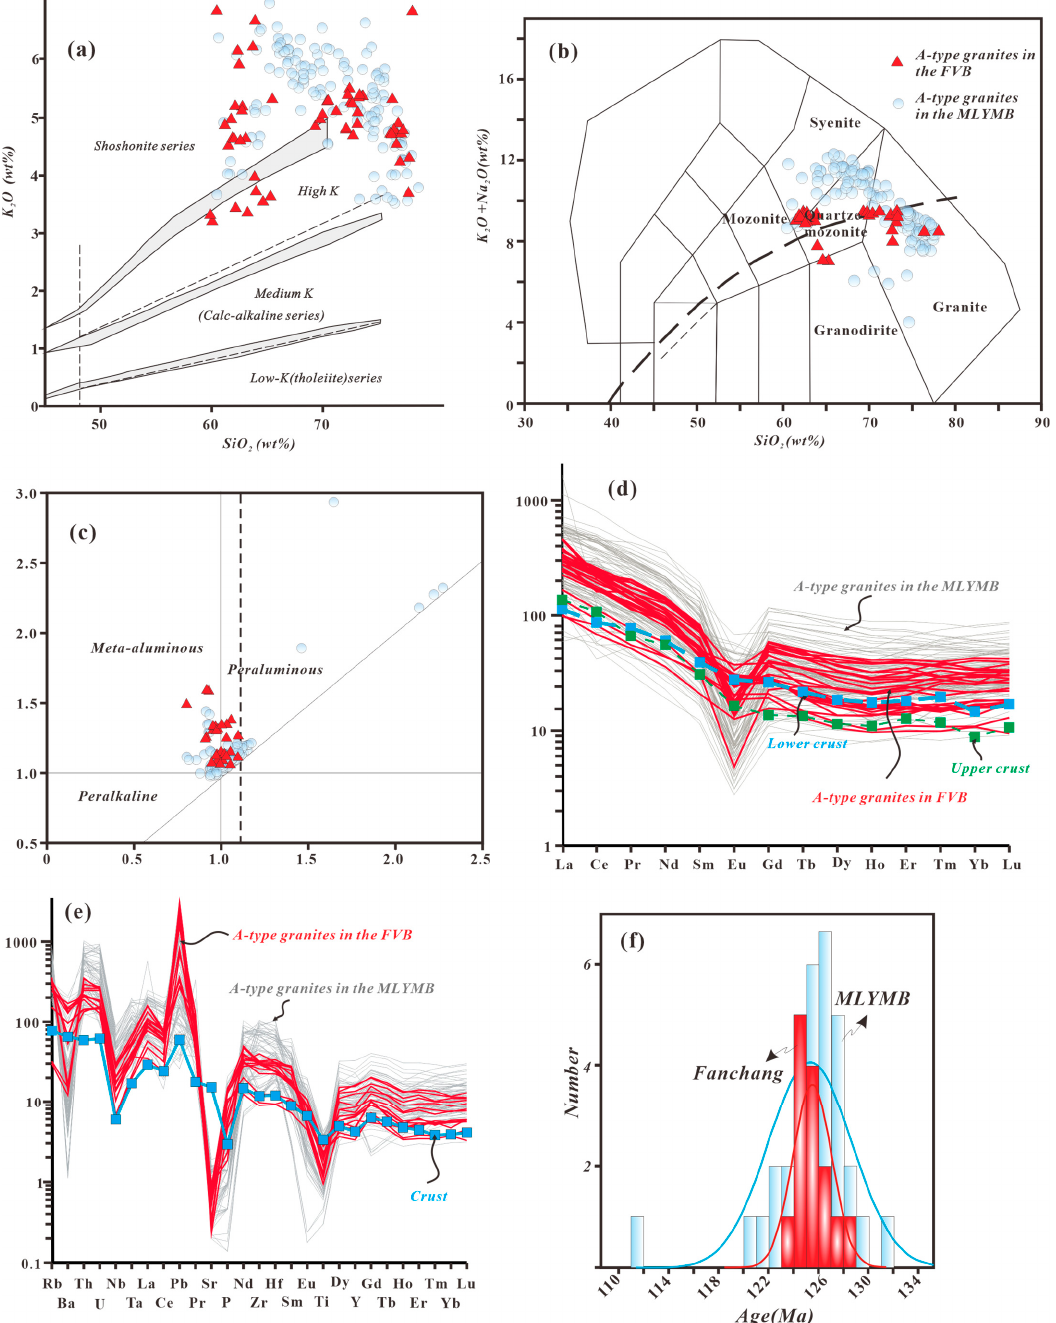
Figure 3. Some basic geochemical diagrams of A-type granites in the FVB and MYLMB. ( a ) K 2 O vs. SiO 2 diagram (after [148]); ( b ) TAS diagram (after [149]); ( c ) A/NK vs. A/CNK diagram (after [148]); ( d ) chondrite-normalized rare earth element patterns (normalization values after [150]), data of the lower and upper crusts are from [151]; ( e ) primitive mantle-normalized trace element patterns (normalization values after [150]), crust data are from [152]; ( f ) crystallization ages. Data source (see Supplement Table S2): major and trace elements of A-type rocks in the FVB are from [46,82,85,88,89]; major and trace elements of A-type granites in other areas of the MLYMB are from [46,84,92–94,96,98, 100,101,107,108]; and crystallization ages of A-type granites in the FVB and other parts of the MLYMB are from